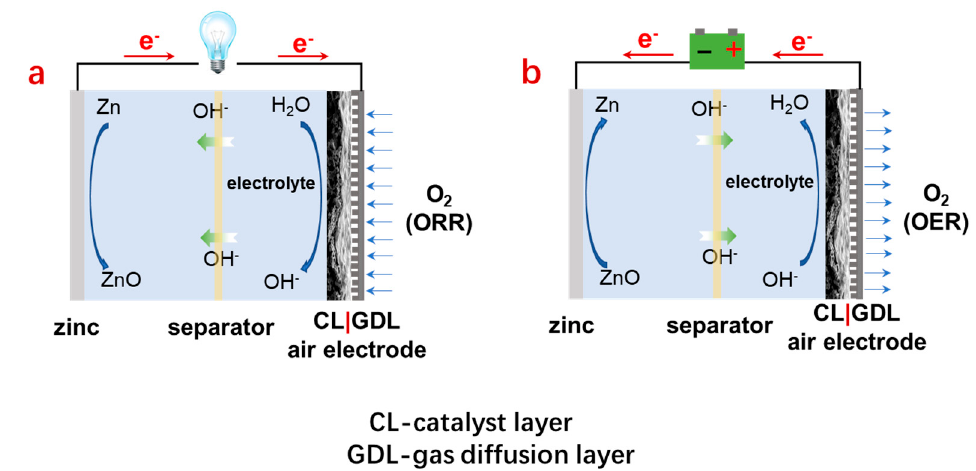
Figure 2. Schematic illustration of configuration of zinc–air batteries (ZABs) and their working principle in the discharge ( a ) and charge ( b ) processes.